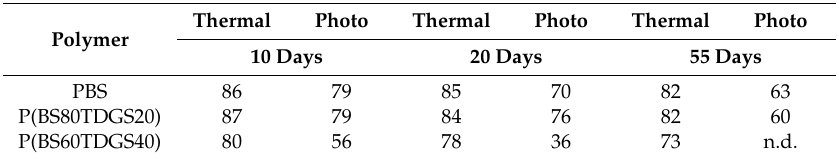
Table 3. Residual M n (%) after thermal and photoaging in the range 0–55